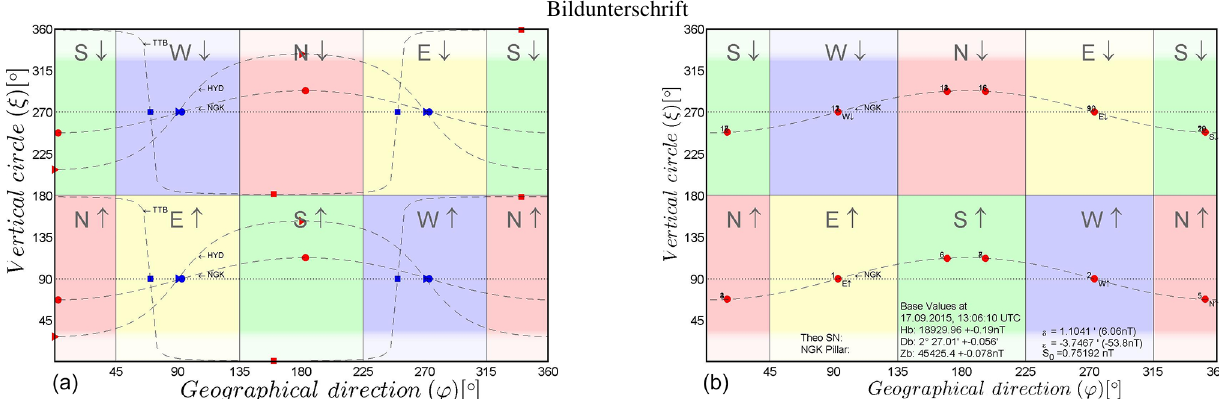
Figure 1. Graphic presentation of possible telescope attitudes of a DI flux theodolite. (a) Dashed lines give orientations with null magne- tometer reading S . These lines are specific to the observatories of Niemegk (NGK), Hyderbad (HYD) and Tatuoca (TTB). Useful sensor orientations at a given observatory are close to this line. The marks represent measurements at these observatories according to the conven- tional scheme. Note the different ϕ values due to different local declination. (b) Measurements taken at the Niemegk Observatory using the new